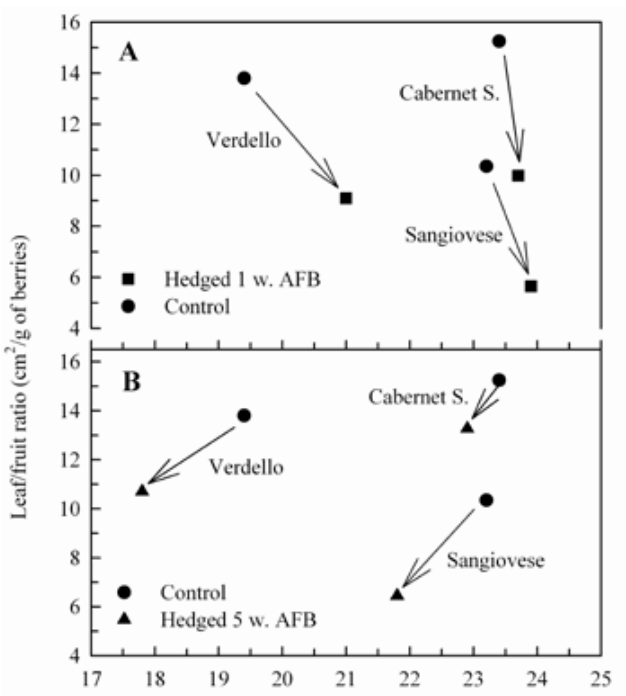
Fig. 6 - Relationship between must total soluble solids and leaf/fruit ratio at harvest in vines of Sangiovese, Cabernet Sauvignon and Verdello either untrimmed or trimmed one (A) and five (B) weeks after full bloom (AFB).